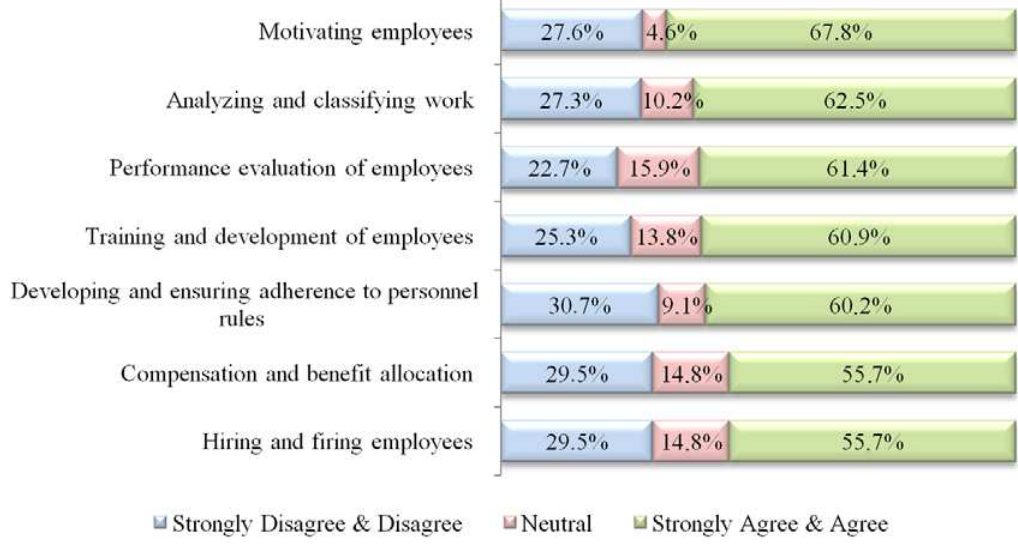
Fig. 1. Levels of agreement with the importance of HR management